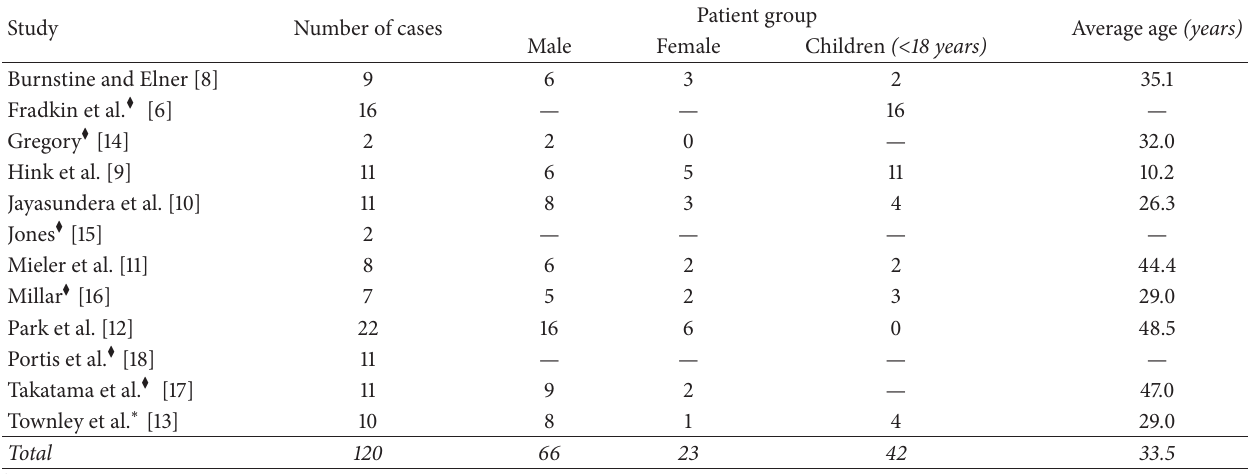
Table 2: Demographic information of patients who sustained golf-related ocular